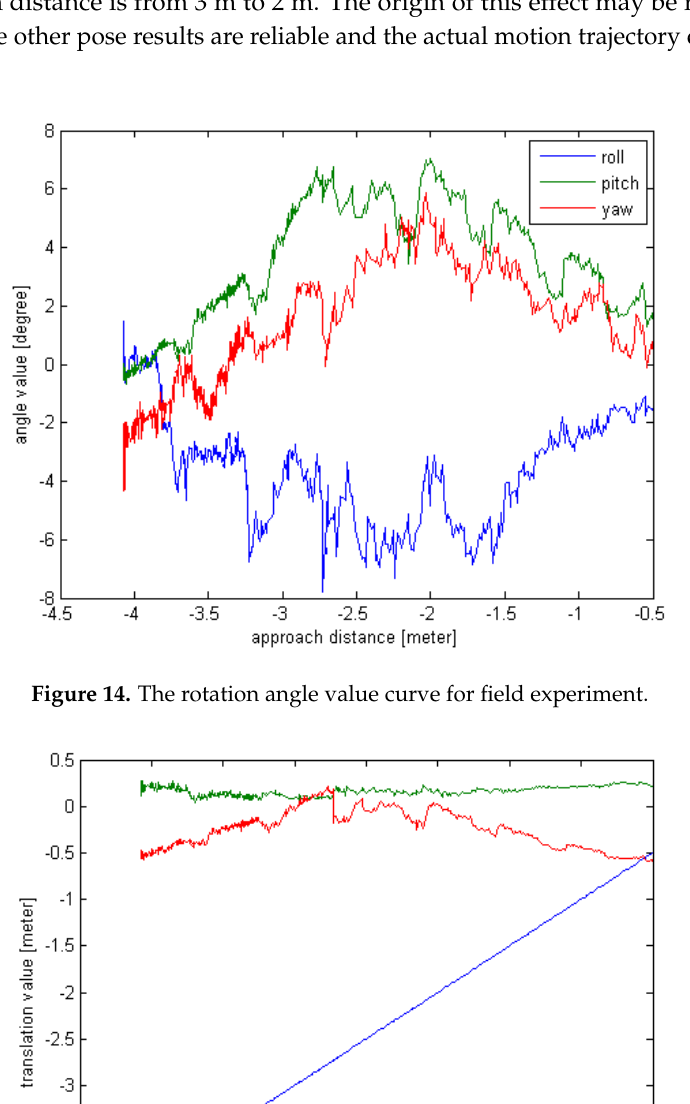
Figure 15. The translation value curve for field experiment.